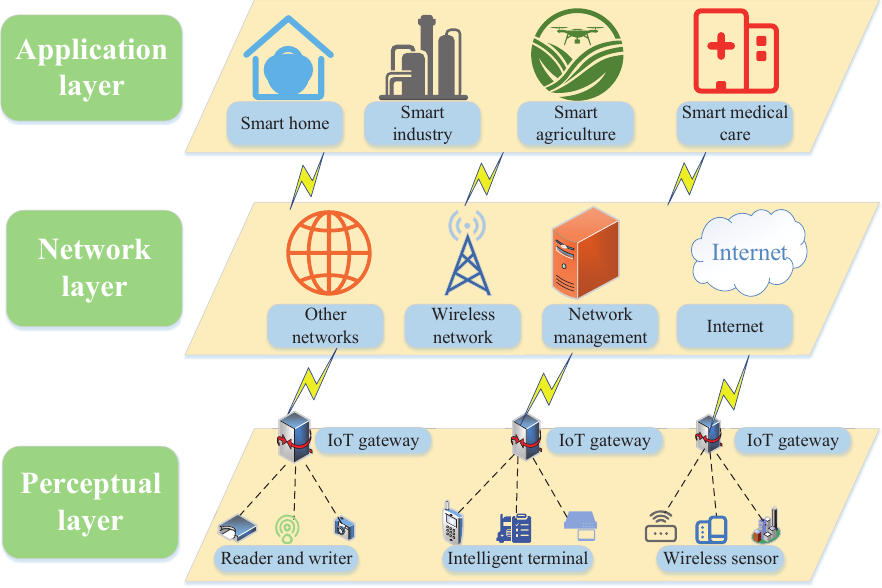
Figure 2. Three-Layer Structure Diagram of the